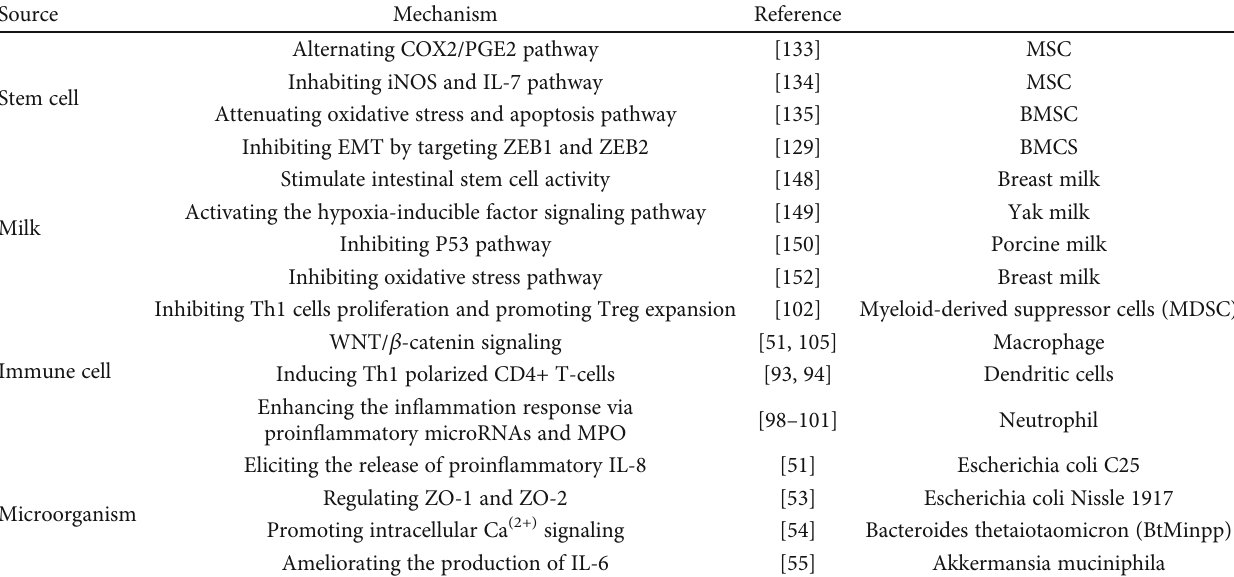
Table 1: Various source of EVs related to